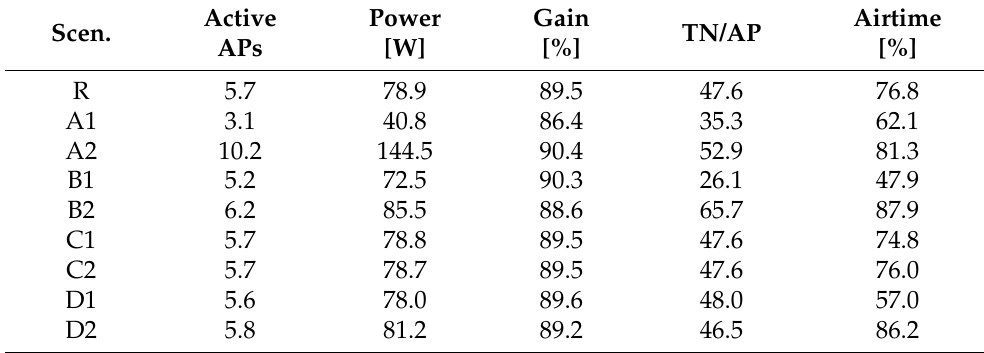
Table 3. Results for the scenarios with D = 21m.